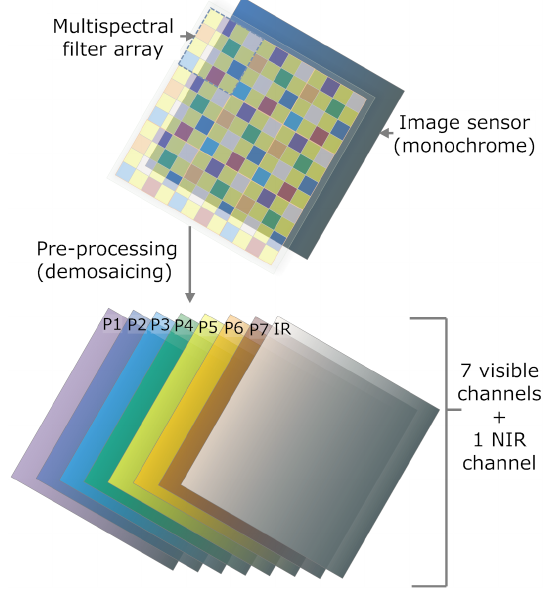
Figure 1. Global scheme of the multispectral imaging system. With the filter array technique, the filter is mounted on a common CMOS image